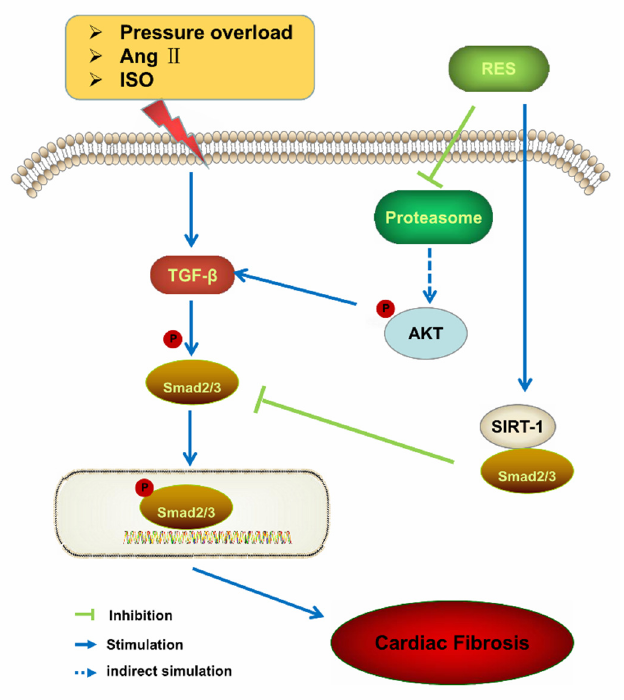
Figure 2. Proposed signaling pathway for the effect of resveratrol against myocardial fibrosis [19,20,22]: isoproterenol (ISO), resveratrol (RES), transforming growth factor β (TGF β ), Sirtuins-1(SIRT-1), angiotensin II (Ang II), protein kinase B (AKT).